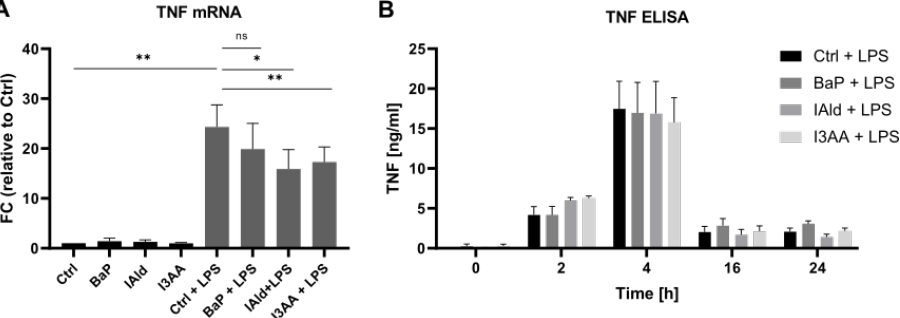
Figure 2. TNF expression and secretion. Macrophages were activated with 100 ng/mL LPS in the presence or absence of the AhR-ligands BaP, IAld, or I3AA. ( A ) The mRNA expression was determined by qPCR after 6 h of treatment. Data were normalized to RPLP0, and the gene expression level was calculated relative to the unstimulated control. Data are shown as mean ± SEM ( n = 4). Significances were calculated by a two-sided, paired t -test (* p ≤ 0.05; ** p ≤ 0.01; ns, not significant). ( B ) Secreted TNF was determined by ELISA after 0, 2, 4, 16, and 24 h of treatment. Data are shown as mean ± SEM ( n = 6 for 2 h and 4 h, n = 5 for 0 h, 16 h, and 24 h).